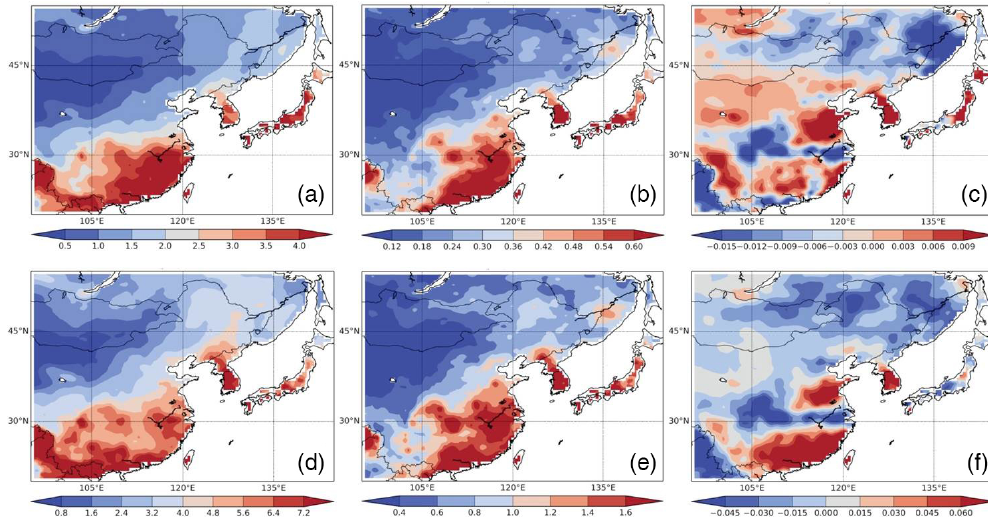
Figure 1. The climatological properties of the annual (upper panels) and summer (lower panels) precipitation for the period 1980–2007 over East Asia: (a, d) the mean climatology, (b, e) the standard deviation, and (c, f) the linear trend of precipitation. These properties are derived from the ensemble of the corresponding properties calculated from the data sets in Table 1.